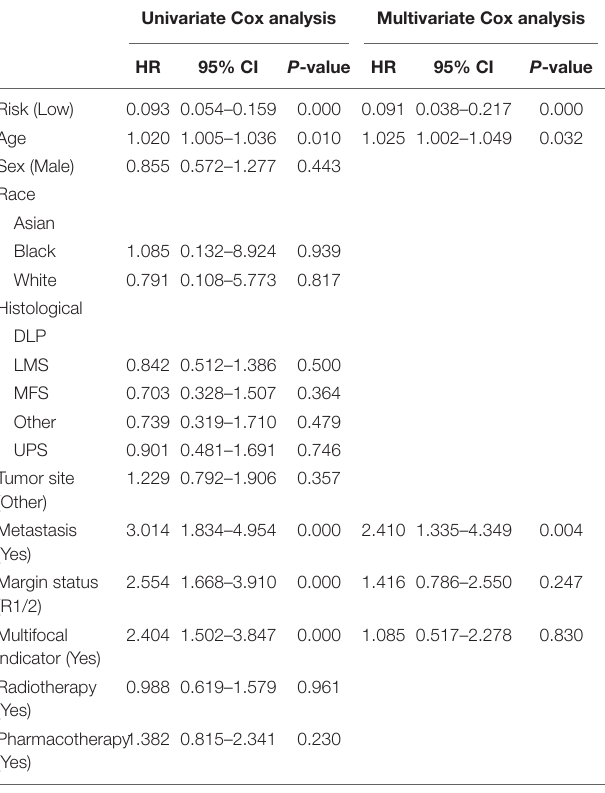
TABLE 2 | Progress free-survival analysis of APA signature and clinical data for